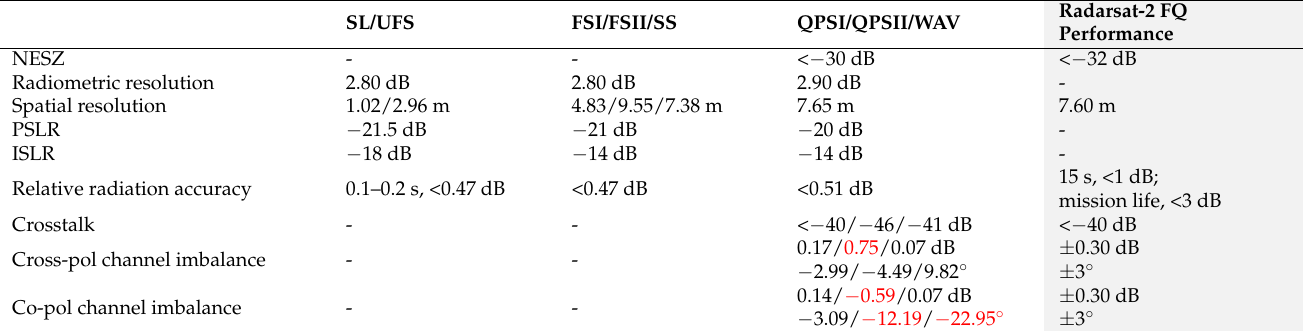
Table 3. Summary of GaoFen-3’s radiometric and polarimetric characteristics in orbit from June 2017 to December 2021. The measurements exceeding the design specification are marked in red. The last column, colored in gray, presents the performance of the Canadian Radarsat-2 Fine Quad (FQ) mode. SL/UFS